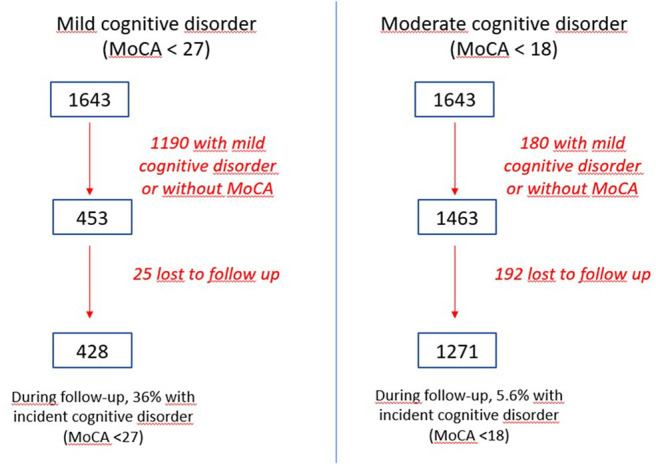
Flow chart of the two analyses.